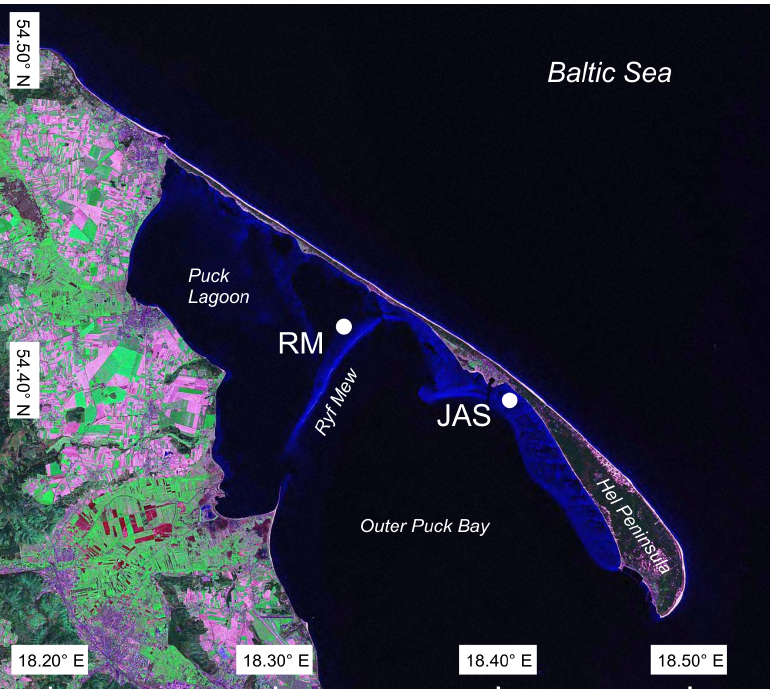
Figure 1 . Location of sampling sites in the Puck Bay. The map is based on Landsat picture taken in 2000, publicized by NASA and located in public domain of Wikipedia (http://en.wikipedia.org/wiki/File:Mierzeja_Helska.jpg).